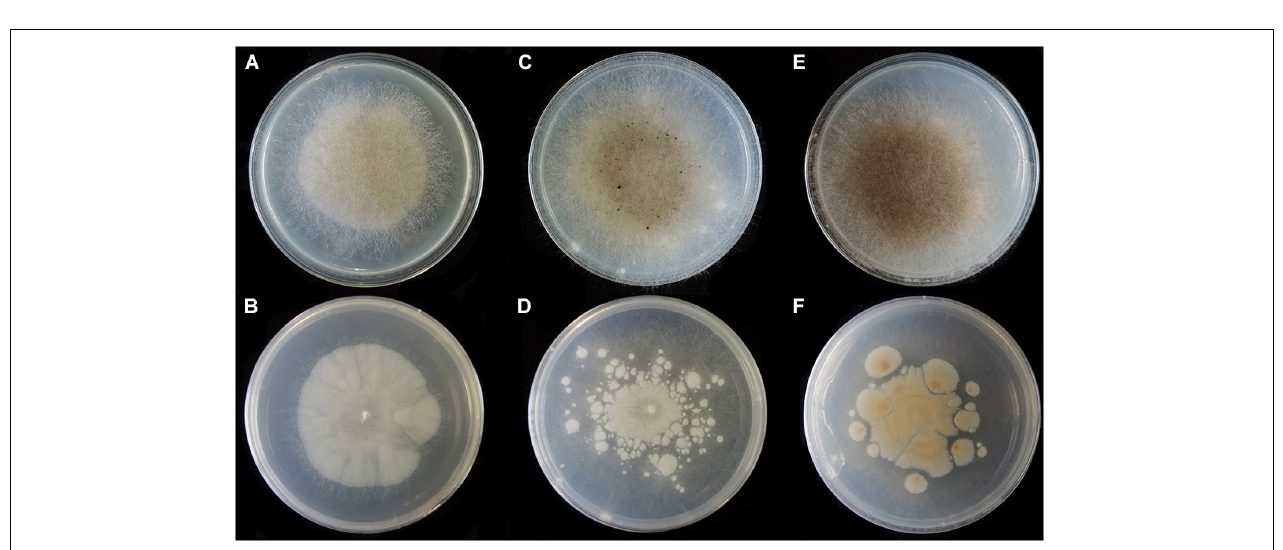
FIGURE 9 | Colonies of Absidia turgida CGMCC 3.16032 at 27 ◦ C after 12 days on MEA (A) obverse, (B) reverse; on SMA (C) obverse, (D) reverse; on PDA (E) obverse, and (F) reverse.